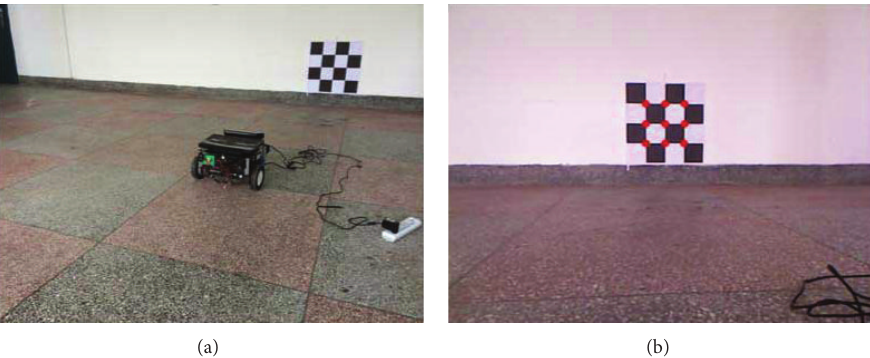
Figure 19: Experimental results. Snapshots of the desired configuration of robot (a). Also, snapshots of the feature motion in desired configuration (b).